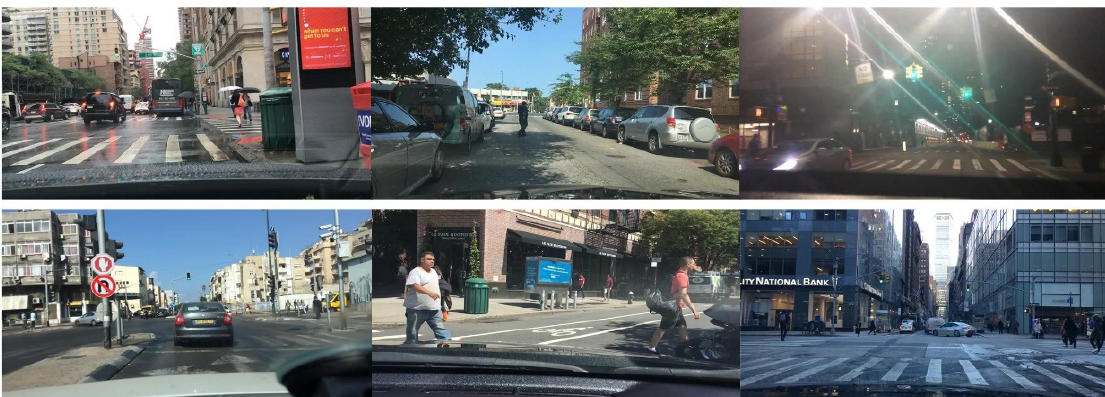
Figure 6. Example of BDD 100 K-Person dataset.